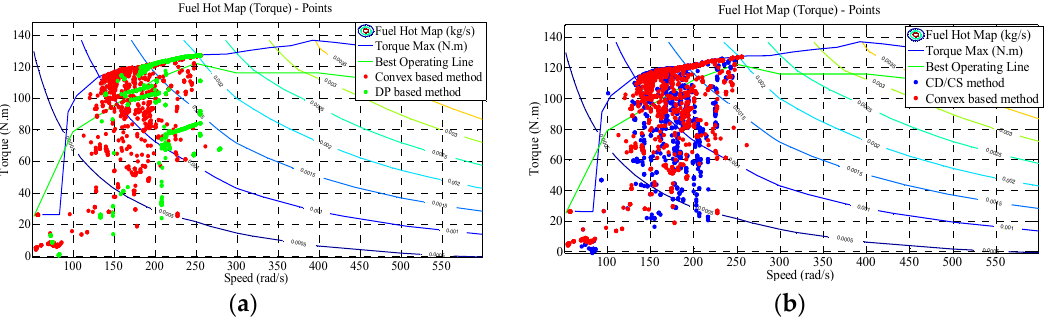
Figure 13. ( a ) Engine efficiency comparison between the convex programming-based strategy and the strategy based on DP; ( b ) Engine efficiency comparison between charging depleting–charging sustaining (CD/CS) strategy and the convex programming-based method. Table 3. Results comparison with standard initial SOC. CD/CS: charging depleting–charging sustaining; DP: dynamic programming; HWFET: Highway Fuel Economy Driving Schedule; NEDC: New European Driving Cycle.